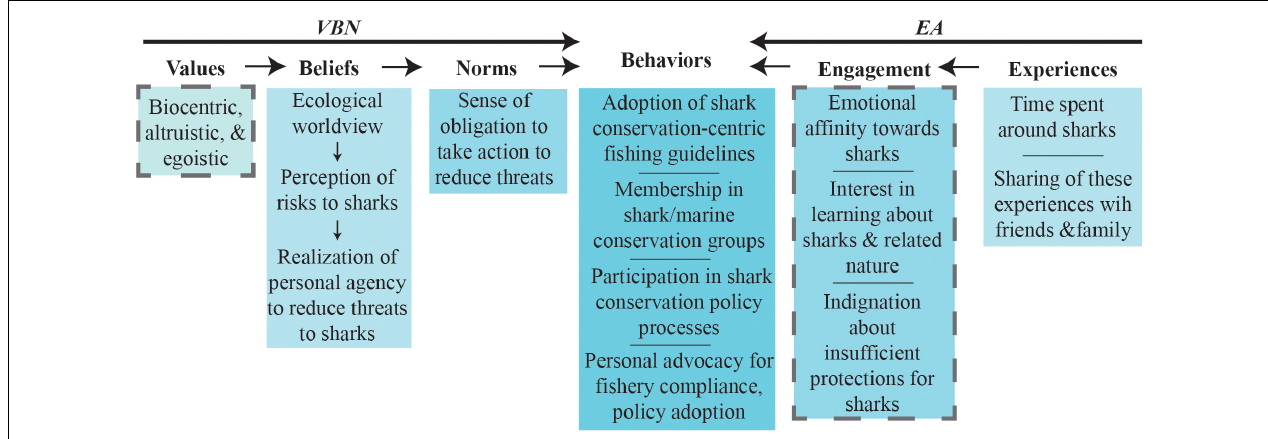
FIGURE 1 | Values have been explained in the context of theoretic frameworks leading to pro-environmental behaviors; here, we show how the Value-Belief-Norm and Emotional Affinity frameworks propose mechanisms leading to a behavior, in the context of sharks. Dashed lines indicate the component of the framework most similar/relevant to “relational values.” This figure is based off of schematics from Stern (2000) and Kals et al.